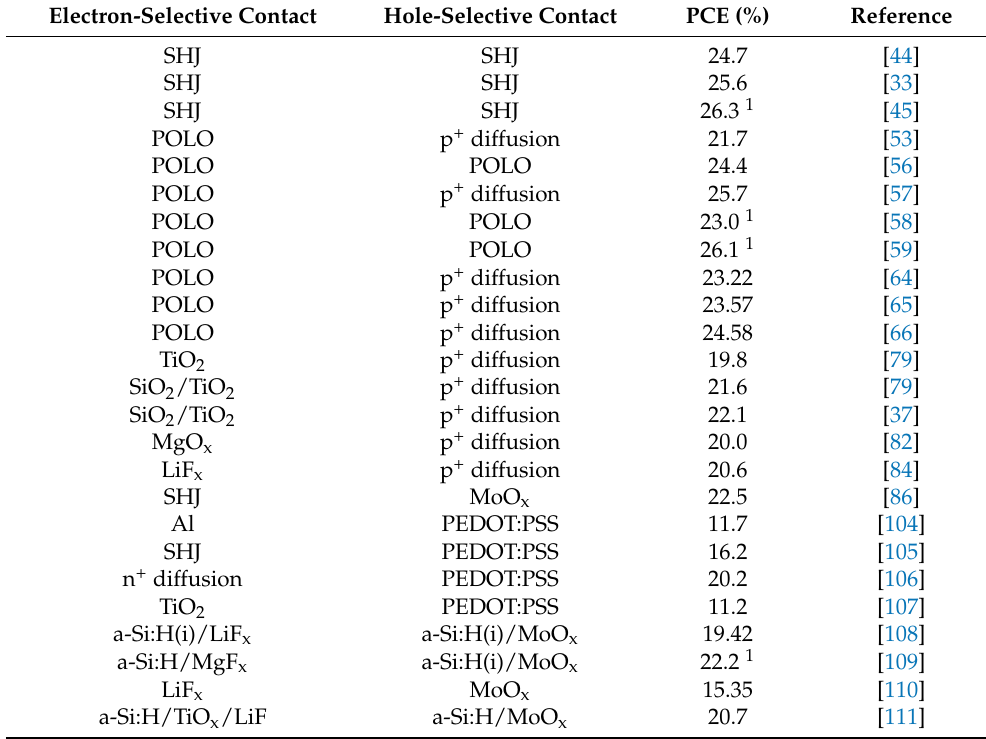
Figure 11. ( a ) Schematic diagram of DASH cell with a − Si:H(i)/MoO x hole-selective contact and a − Si:H(i)/TiO x /LiF electron − selective contact; ( b ) current density − voltage characteristics under illumination of champion cell; ( c ) internal, external quantum efficiency and reflection spectra of devices (Reprinted with permission from Ref. [111] ACS Energy Lett. 2018, 3, 508 − 513. 2018 American Chemical Society). Table 1. PCE of recent high-performance c-Si solar cells with passivating contacts. Electron-Selective